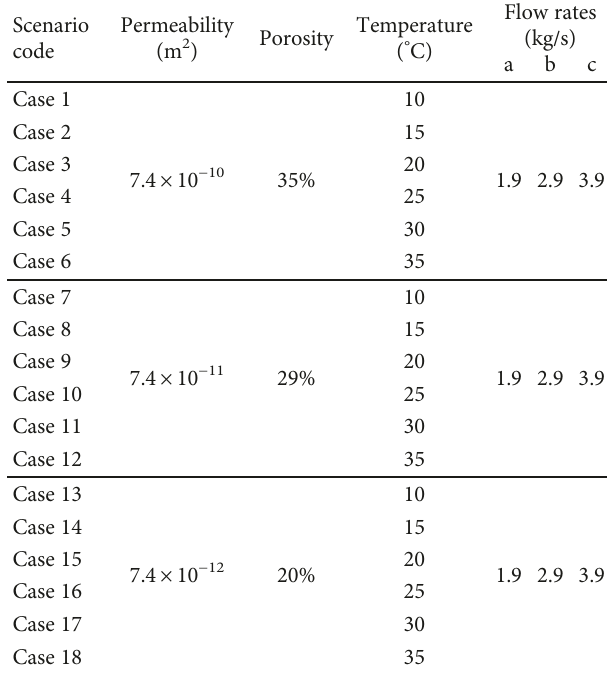
Table 3: Karst ratio of the Wulong tunnel. The starting position of each section from the tunnel inlet (m)